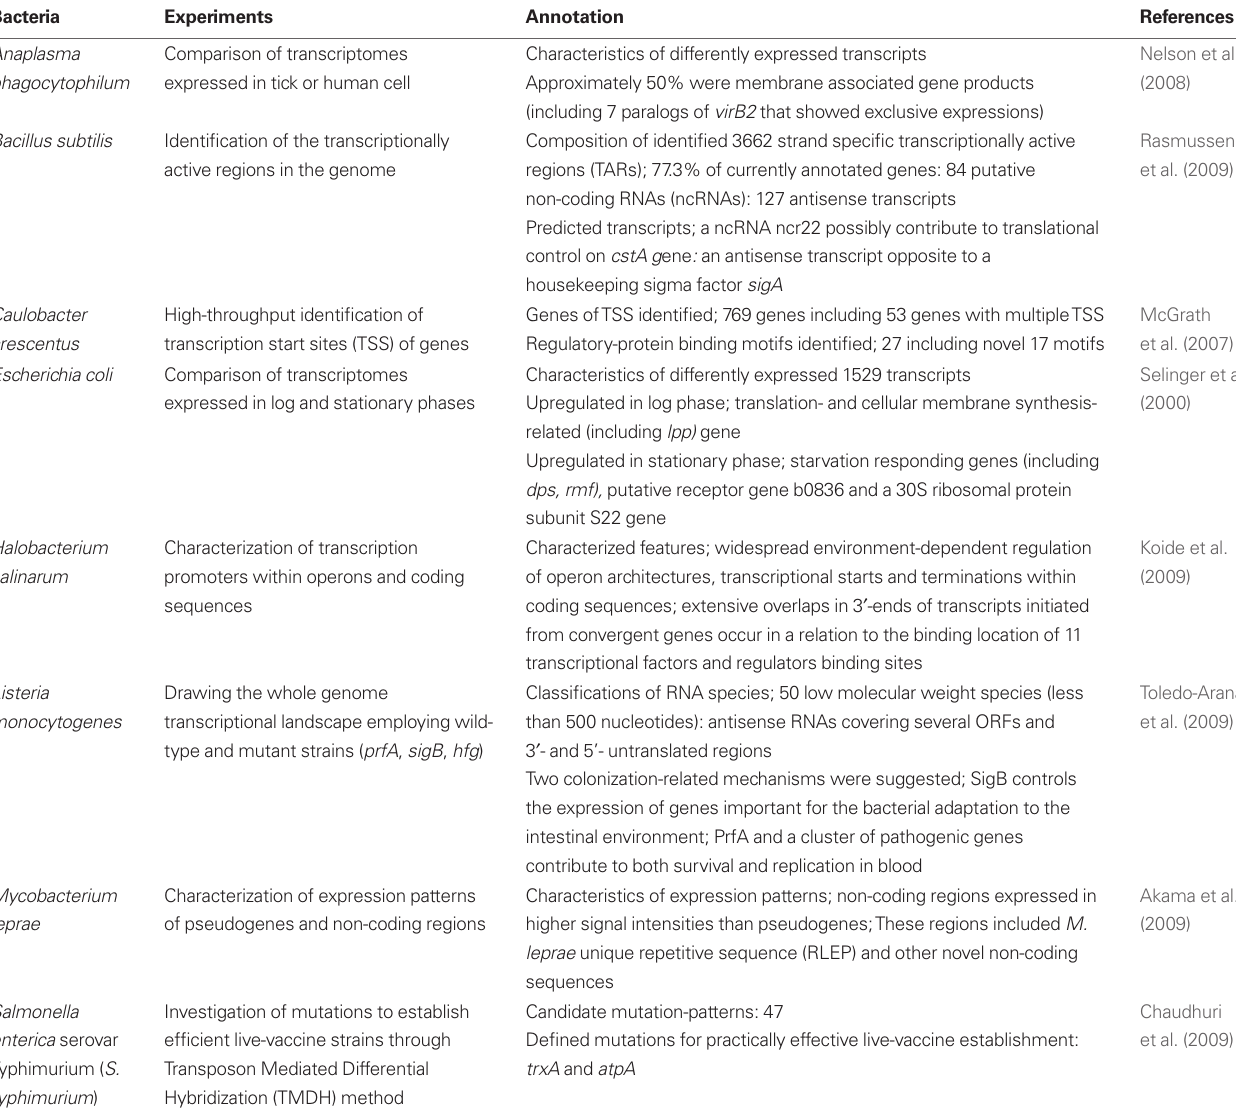
Table 1 | Bacterial transcriptome analyses using genomic tiling